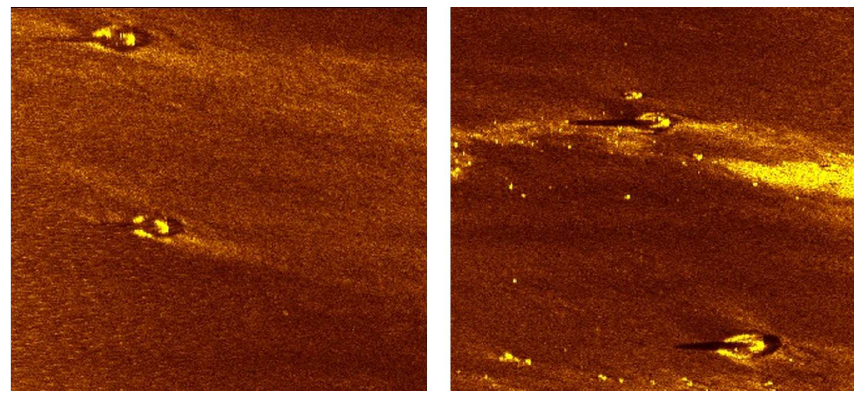
Figure 2. Sonograms of underwater mines achieved from side scan